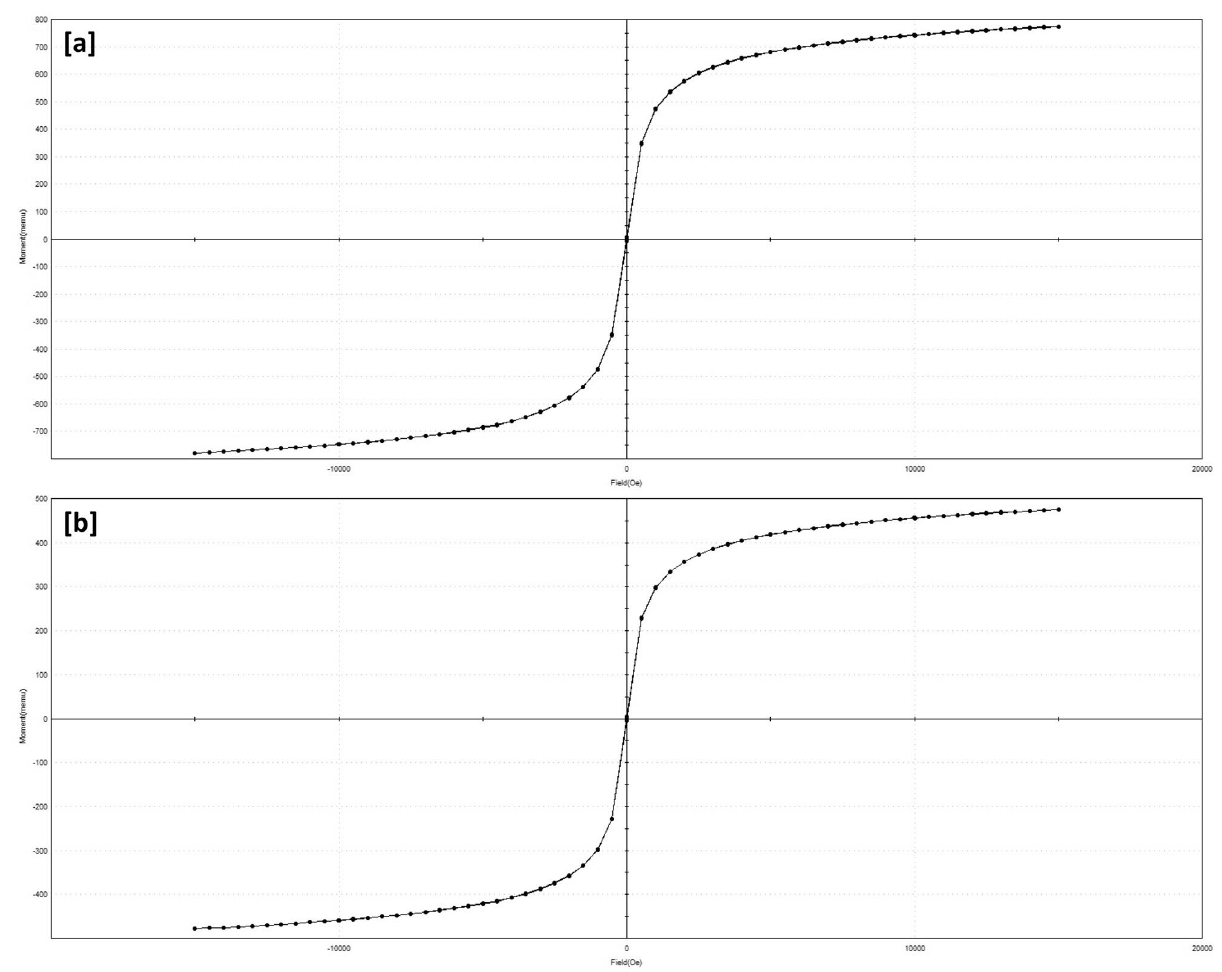
Figure 6. Magnetic hysteresis curves of ( a ) Fe 3 O 4 and ( b ) In 2 O 3 /MoS 2 /Fe 3 O 4